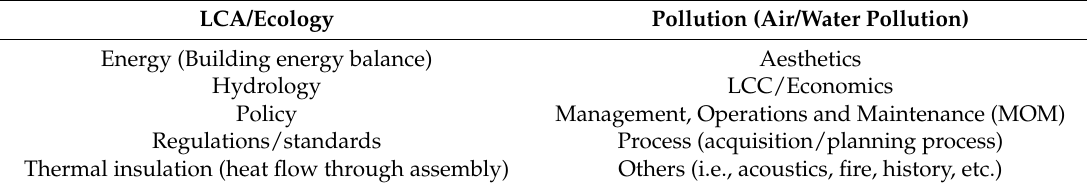
Table 1. Topic categories.